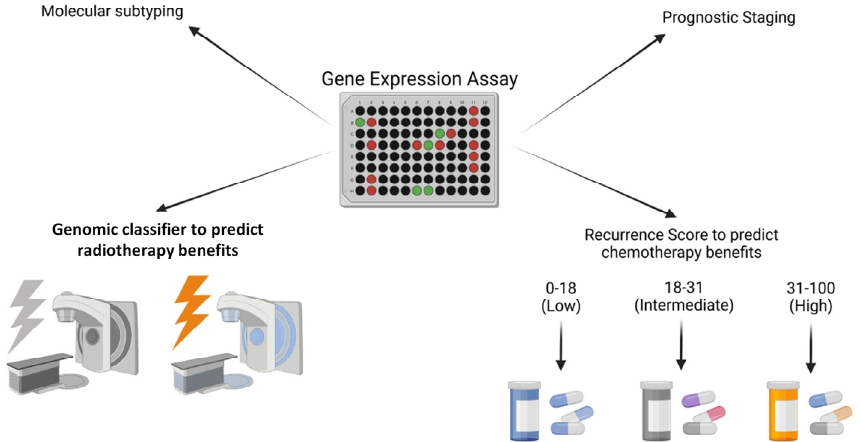
Figure 1. Schematic illustrating the use of a generic genomic assay to help with the process of staging and subtyping breast cancer but also with the ability to provide predictive information with regard to radiation therapy and chemotherapy.